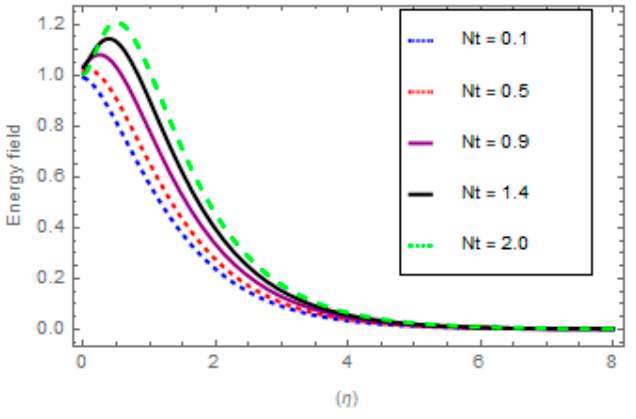
Figure 10. Result of Nt via θ ( η ) .